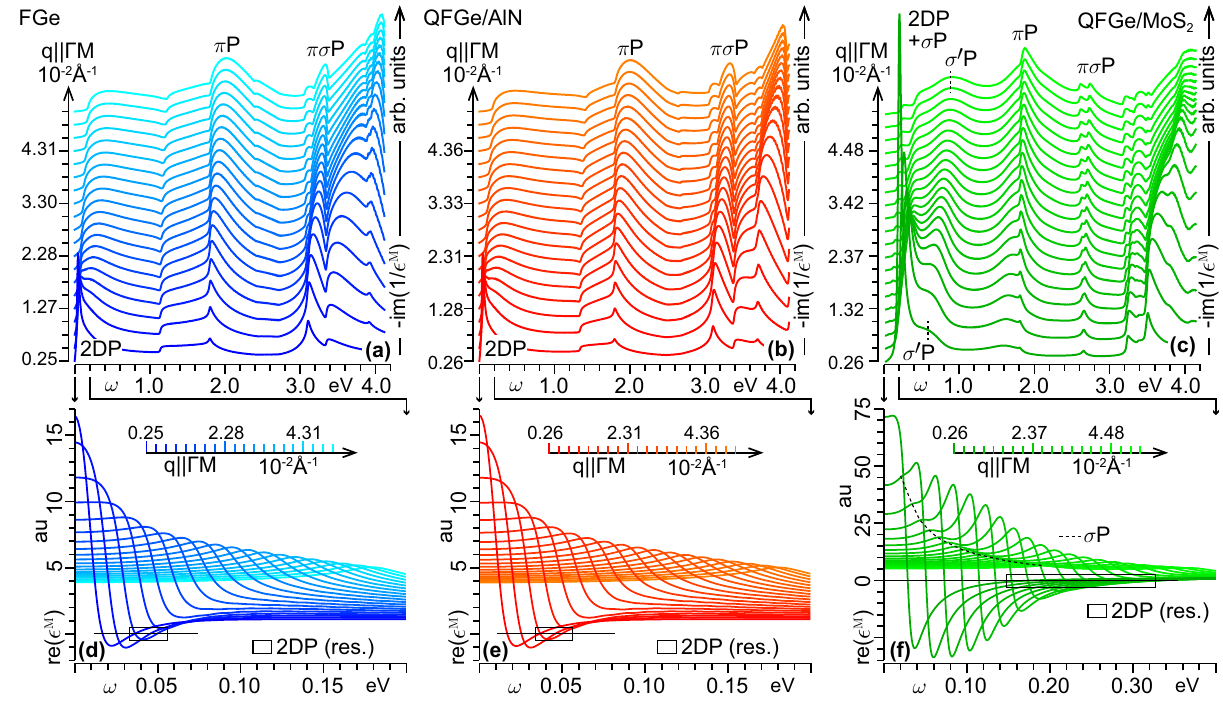
im ( 1 /ǫ m ) , in arb. units] of ( a ) FGe, ( b ) QFGe on AlN , and Figure 4. (Top) Intrinsic loss functions [ ∝− ( c ) QFGe on MoS 2 displayed as vertically shifted plots vs ω< 4.2 eV, for some fixed sampled momenta Ŵ M . The slight differences in the q -values of the three monolayers are a consequence q < 5.4 10 − 2 Å − 1 with q × (cid:31) of their different lattice constants (see Fig. 1). The ω< 0.4 eV dispersive features originate from intraband charge density oscillations, namely the 2DP mode in ( a ), ( b ), and the 2DP+ σ P modes in ( c ), with the highest 0.02 eV, being 20% lower than that of QFGe on MoS 2 , at 0.04 eV. The peak of FGe and QFGe on AlN , at ∼ ∼ ω> 0.4 eV dispersive peaks exhibit similar intensities at similar momentum transfers, being a signature of different interband plasmons, including the σ ′ P mode [dashed lines in ( c )], plus the more conventional π P and πσ P modes in ( a )–( c ). (Bottom) Real macroscopic permittivity [ re (ǫ m ) , in atomic units (au)] of ( d ) FGe, ( e ) QFGe on AlN , vs ω< 0.2 eV, and ( f ) QFGe on MoS 2 vs ω< 0.4 eV, with the same sampled momenta of ( a )–( c ). The black boxes highlight the undamped 2DP resonances, and the dashed line follows the effect of the damped σ